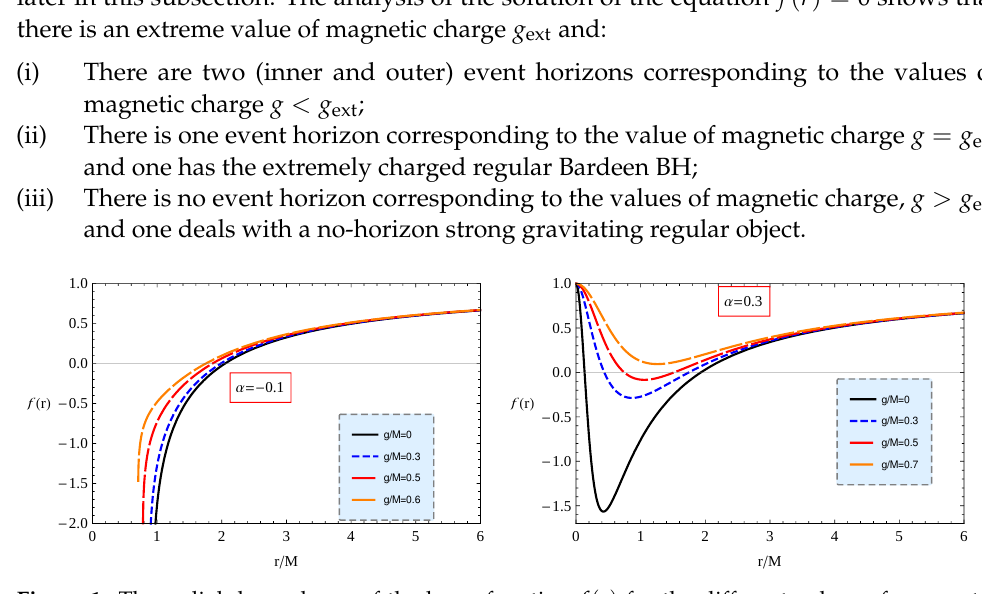
Figure 1. The radial dependence of the lapse function f ( r ) for the different values of parameter. left panel is for α = 0.1 and the right one is for α =